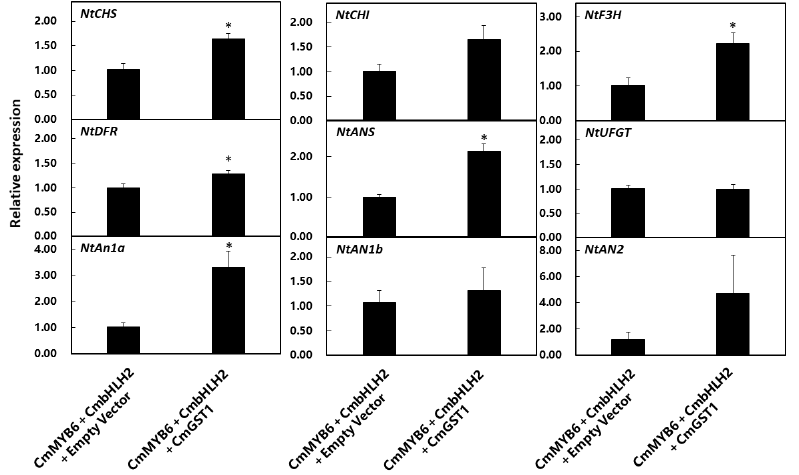
Figure 6. Structural genes and transcriptional factors’ relative expressions of transient overexpres- sion of CmMYB6-bHLH2 and empty vector or CmGST1 in tobacco ( Nicotiana tabacum ) leaves. Data were means (±SE) from three independent biological replicates. Asterisks indicate significant dif- ferences (* P < 0.05).